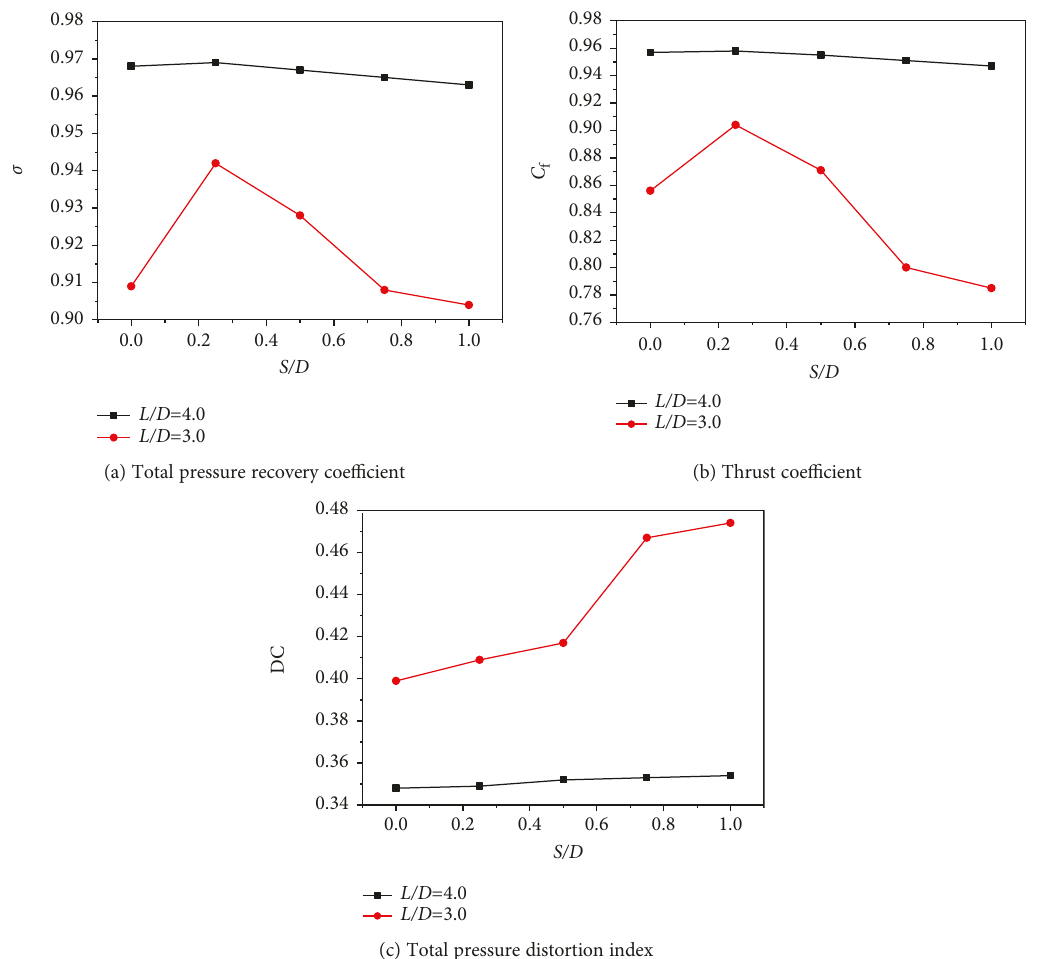
Figure 13: Comparison of performances of nozzles with di ff erent S / D